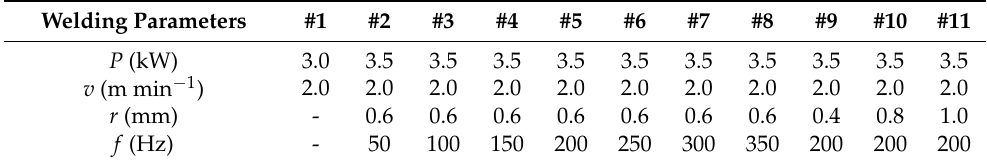
Figure 1. Oscillating laser beam welding system of 5A06 alloy lock bottom weld. Table 2. The processing parameters, where P denotes laser power, v denotes welding speed and r and f denote oscillation radius and frequency, respectively.